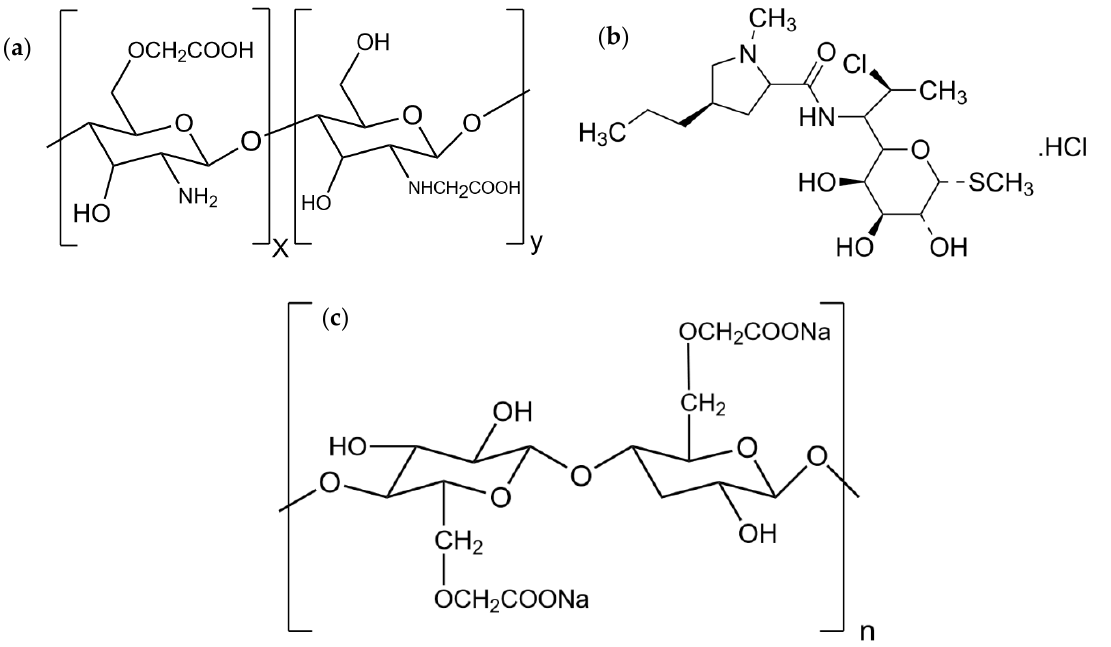
Figure 1. Chemical structure of carboxymethyl chitosan (CMCS) ( a ); clindamycin HCl ( b ); and sodium carboxymethyl cellulose (SCMC) ( c ).